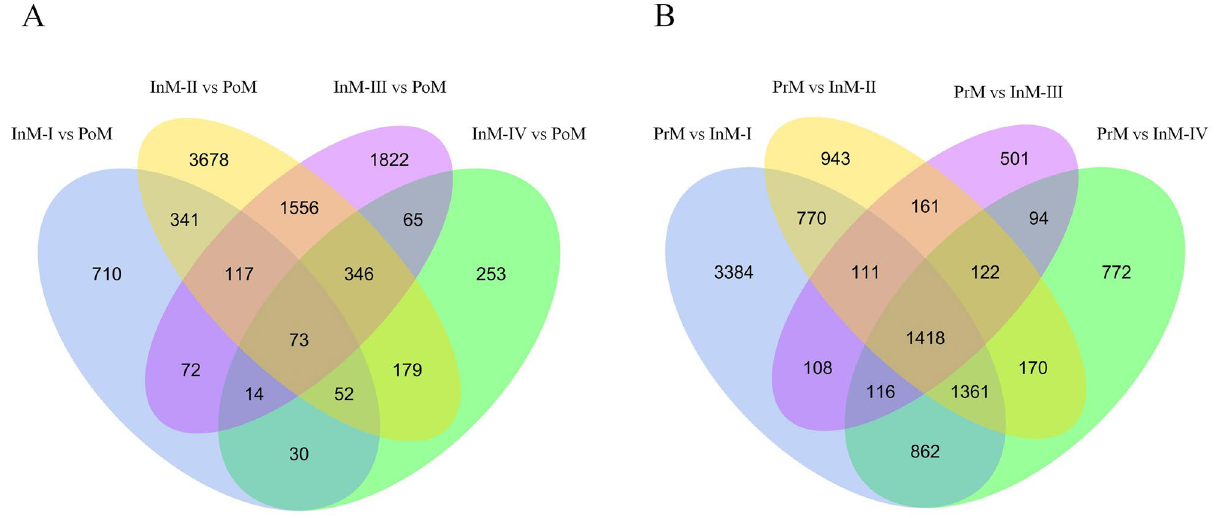
Figure 5. Venn diagram for the number of DEGs between comparisons of InM vs PoM and PrM vs InM. ( A ) InM-I vs PoM, InM-II vs PoM, InM-III vs PoM, and InM-IV vs PoM; ( B ) PrM vs InM-I, PrM vs InM-II, PrM vs InM-III, and PrM vs